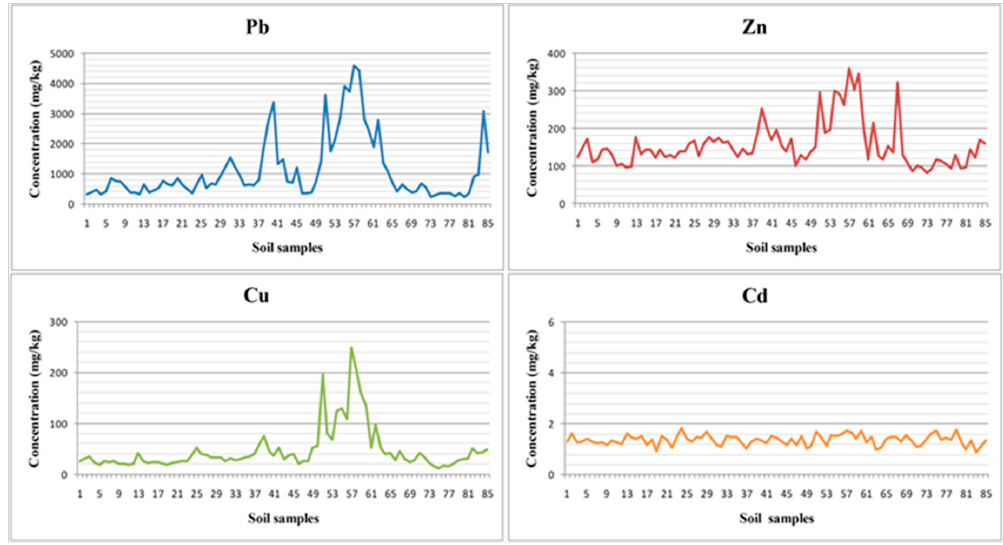
Figure 5. Mean (n = 85) variation in concentrations of the four heavy metals found in the study site.